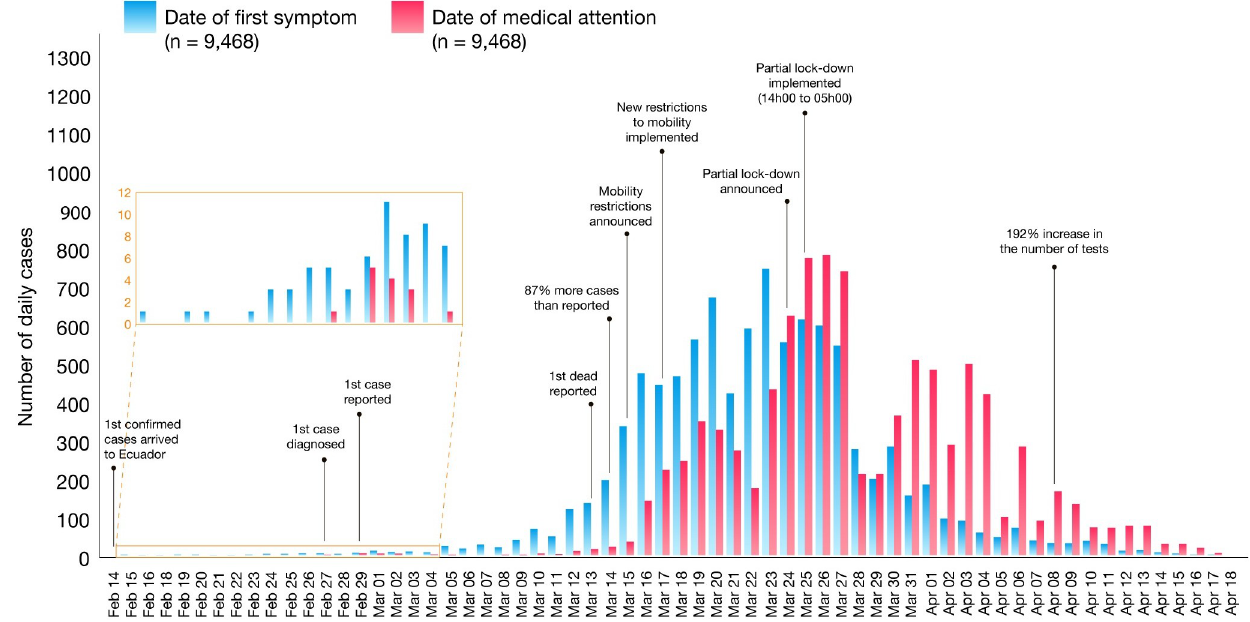
Fig 3. Epidemiological curves of COVID-19 cases by date of onset of symptoms (blue) and date of diagnosis (red), from 14 February to 18 April 2020. The first case in Ecuador was diagnosed on 27 th February but notified on February 29 th .